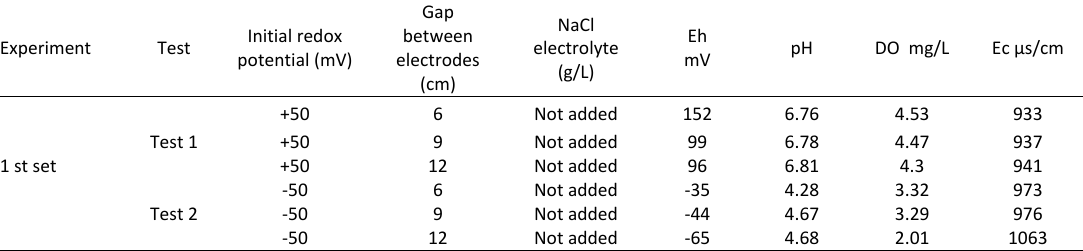
Table 1: The summary of the experimental conditions and development of several quality parameters of rainwater (after PEC) with the initial anodic potential (2.5V); Ec (703 µs/cm); pH (7.3); electrode material: Ti/TiO 2 - Gr